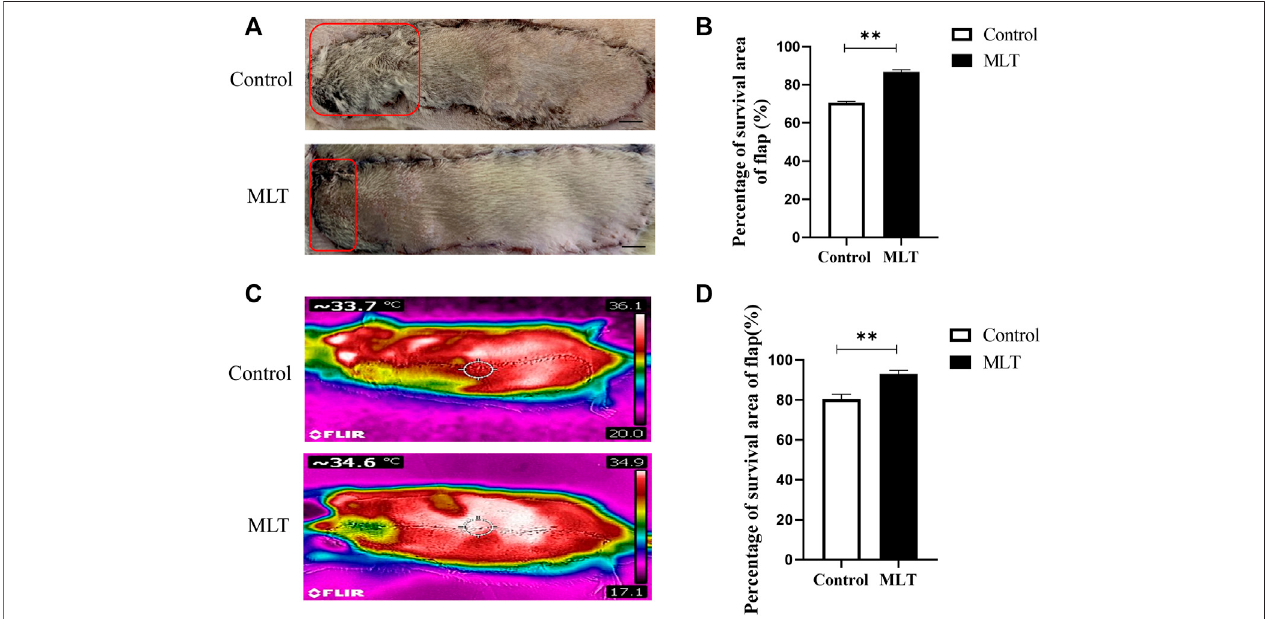
FIGURE 1 | MLT improved multiterritory perforator fl ap survival and reduced multiterritory perforator fl ap necrosis. (A) Images of the skin fl aps taken 7 days post- operation. The red pane is the area of fl ap necrosis we marked. Scale bar: 1 cm (B) Percentage of survival area of fl ap. Signi fi cant differences between the groups are indicated by ** p < 0.001. (C) Images of the skin fl aps taken by infrared detector. (D) Skin fl ap survival rate calculated by fl ap blood fl ow temperature. Values are the mean ± SEM, n = 6 per group. Signi fi cant differences between the groups are indicated by ** p < 0.001. AbbreviationsMLT,